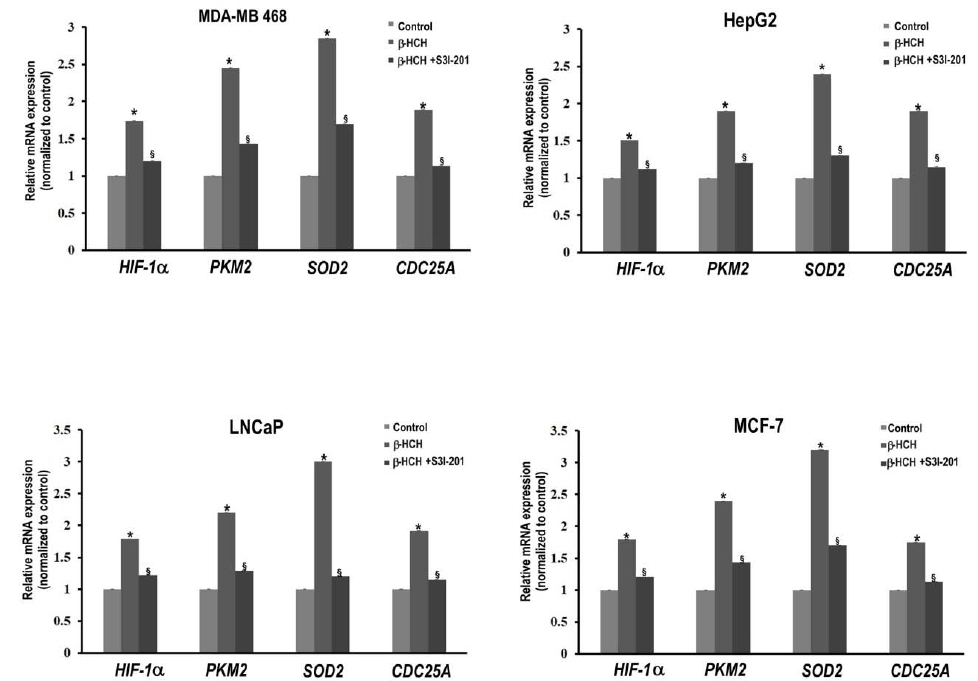
Figure 8. RT ‐ qPCR analysis of STAT3 target genes involved in oxidative ‐ stress and energy Figure 8. RT-qPCR analysis of STAT3 target genes involved in oxidative-stress and energy metabolism metabolism ( PKM2 , HIF ‐ 1 α , SOD2 , and CDC25A ). Analysis was performed after 8 h treatment with ( PKM2 , HIF-1 α , SOD2 , and CDC25A ). Analysis was performed after 8 h treatment with 10 µ M β -HCH, 10 μ M β‐ HCH, as well as on cells pre ‐ incubated with a specific STAT3 inhibitor (S3I ‐ 201) before as well as on cells pre-incubated with a specific STAT3 inhibitor (S3I-201) before β -HCH treatment. Statistically significant differences ( p < 0.05) between β -HCH treated and β -HCH untreated cells are marked by *, while statistically significant differences ( p < 0.05) between β -HCH treated and pre-incubated or not with a specific STAT3 inhibitor are marked by